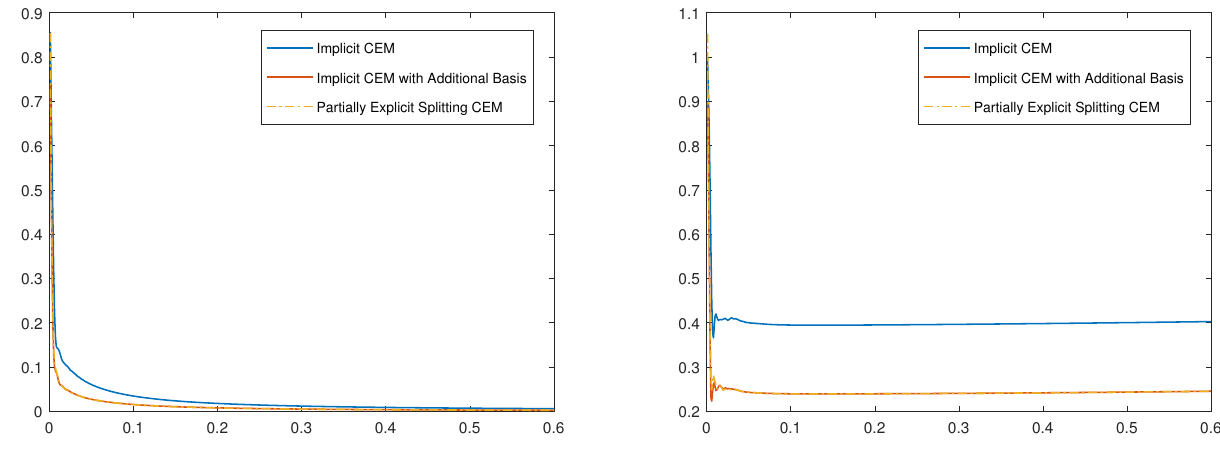
Figure 5. α = 0.005, dt = 0.003. Left : L 2 error. Right : Energy